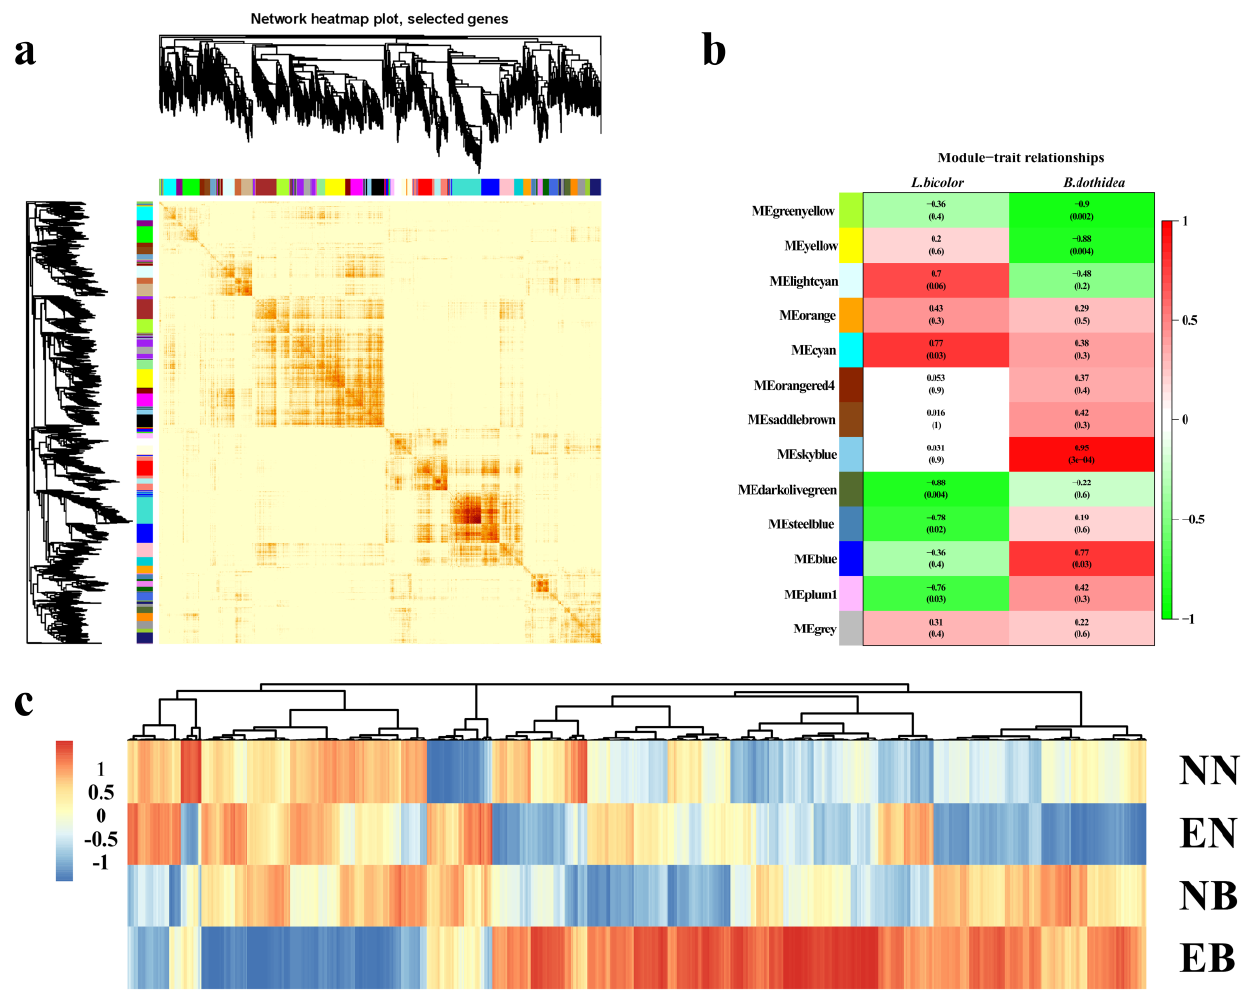
Figure 2. ( a ) The correlation heat map of the genes between the modules. ( b ) The heat map of the correlation between each module and the trait. Pearson’s correlation coefficients between modules and fungal inoculation are shown, accompanied by the corresponding P value in brackets. From red to green, the correlation probability is from high to low. Each module is identified by color. ( c ) A heat map of the expression levels of 661 DEGs in the four groups. From red to blue, the expression level was from high to low.